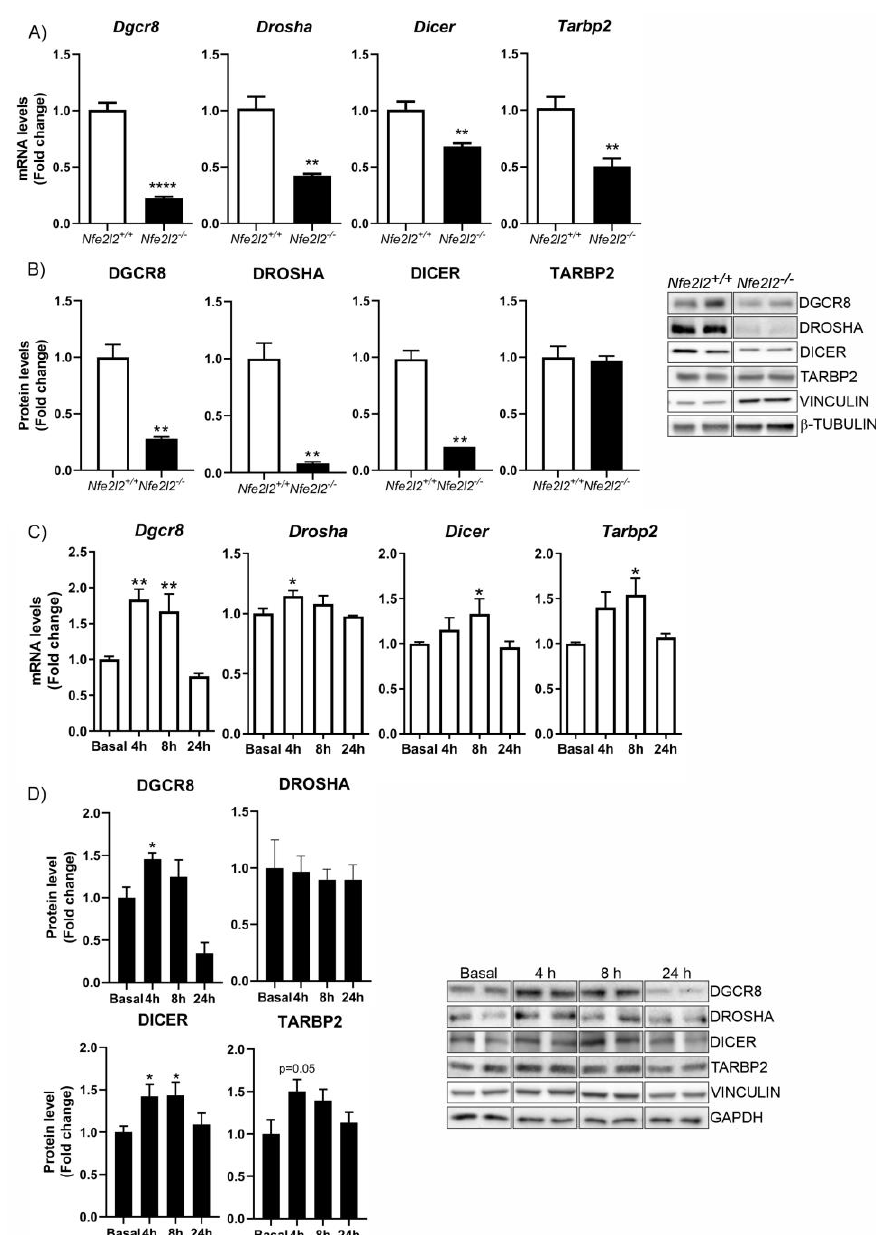
Figure 3. Impact of NRF2 on the expression levels of several proteins implicated in miRNA biogenesis. ( A ) qPCR analysis of the levels of Dgcr8 , Drosha , Dicer1 , and Tarbp2 mRNAs n = 3 − 4 samples ± SEM. ( B ) In the same cells described in ( A ), the levels of DGCR8, DROSHA, DICER, and TARBP2 proteins were analyzed via immunoblotting and quantification based on densitometry using the same samples as in ( A ). n = 3 − 4 samples per experimental group ± SEM. Asterisks denote significant differences: ** p < 0.01 and *** * p < 0.0001, comparing the indicated group with the wild-type mice according to a Student’s t- test. Time-course analysis of treatment of hippocampal HT22 cells with DMF (20 µ M). ( C ) qPCR analysis of the levels of Dgcr8 , Drosha , Dicer1 , and Tarbp2 mRNAs. n = 4 − 5 samples ± SEM. ( D ) In the cells described in ( C ), the levels of DGCR8, DROSHA, DICER, and TARBP2 were analyzed via immunoblotting and respective quantification based on densitometry. n = 3 − 4 samples per experimental group ± SEM. The one-way ANOVA test with a Newman–Keuls posterior test was used to evaluate differences in significance between groups: * p < 0.05 and ** p < 0.01 compared to basal